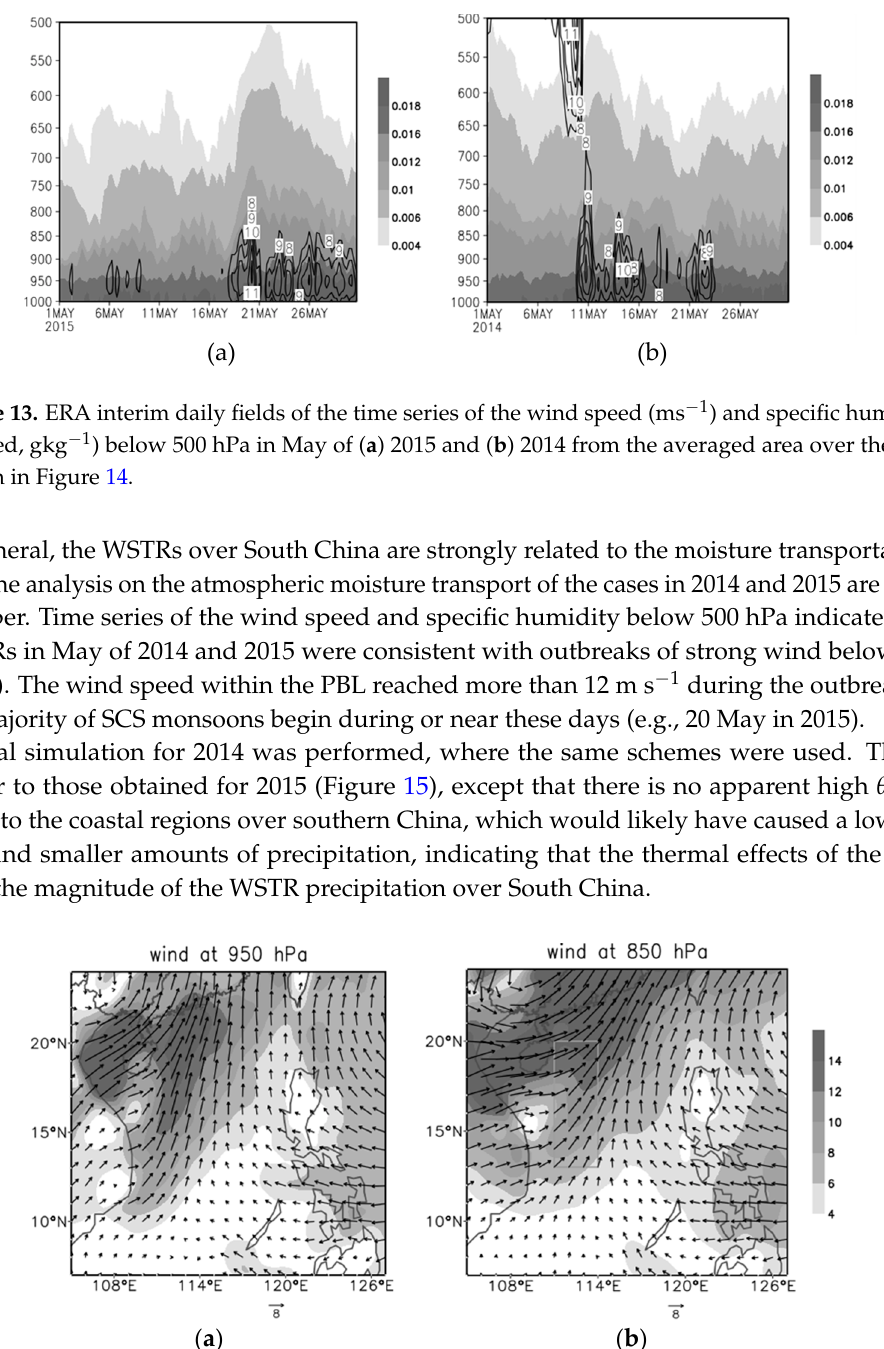
( b ) Figure 13. ERA interim daily fields of the horizontal wind speed (shaded, ms − 1 ) and wind barbs at ( a ) 950 hPa and ( b ) 850 hPa at 0000 UTC on 11 May 2014; the green rectangle denotes the area illustrated in Figure 14. In general, the WSTRs over South China are strongly related to the moisture transportation